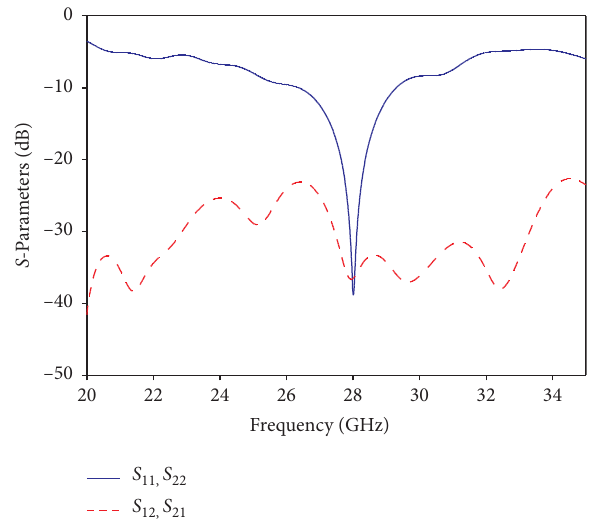
Figure 7: S parameters of symmetric MIMO